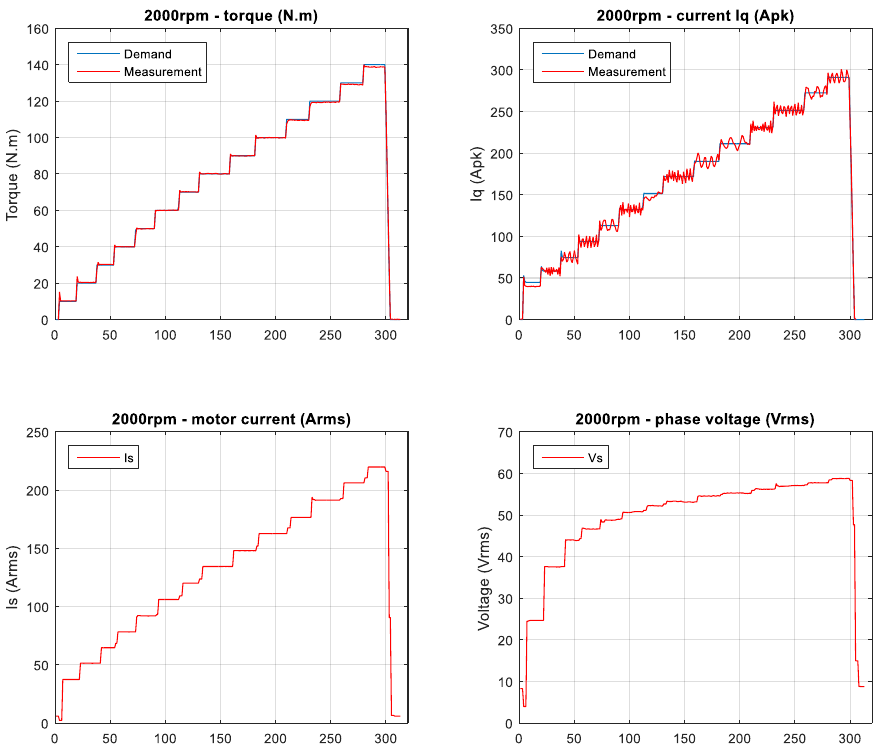
Figure 7. Torque-step validations in the optimal tuning of the motor control map.